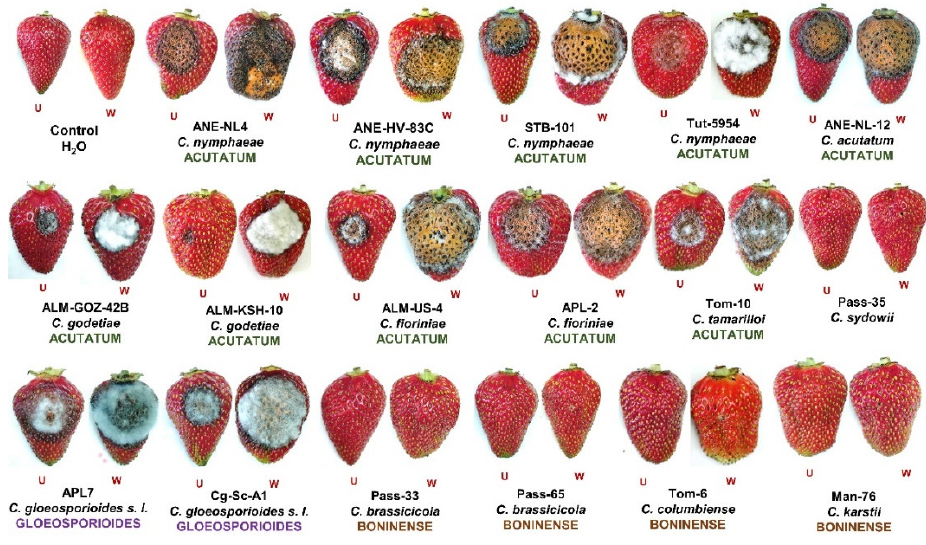
Figure 4. Anthracnose lesions on detached unwounded (UW) and wounded (W) strawberry fruits 7 days after inoculation for each representative isolate and species, within each Colletotrichum species complex used in this